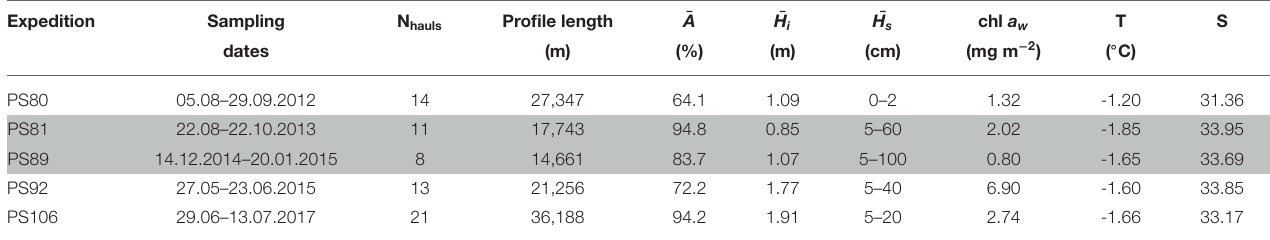
TABLE 1 | Table with listed, for each expedition, the number of profiles considered in the analysis (N hauls ), the total profile length, the mean ice concentration ( ¯ A ), mean total ice thickness ( ¯ H i ) and mean snow depth ( ¯ H s ), under-ice water chl a (chl a w ) multiplied by the vertical section of the SUIT (2m) to obtain integrated values, temperature and